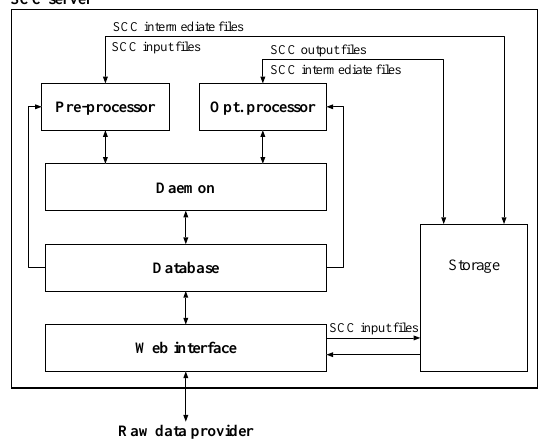
Figure 1. Block structure of the Single Calculus